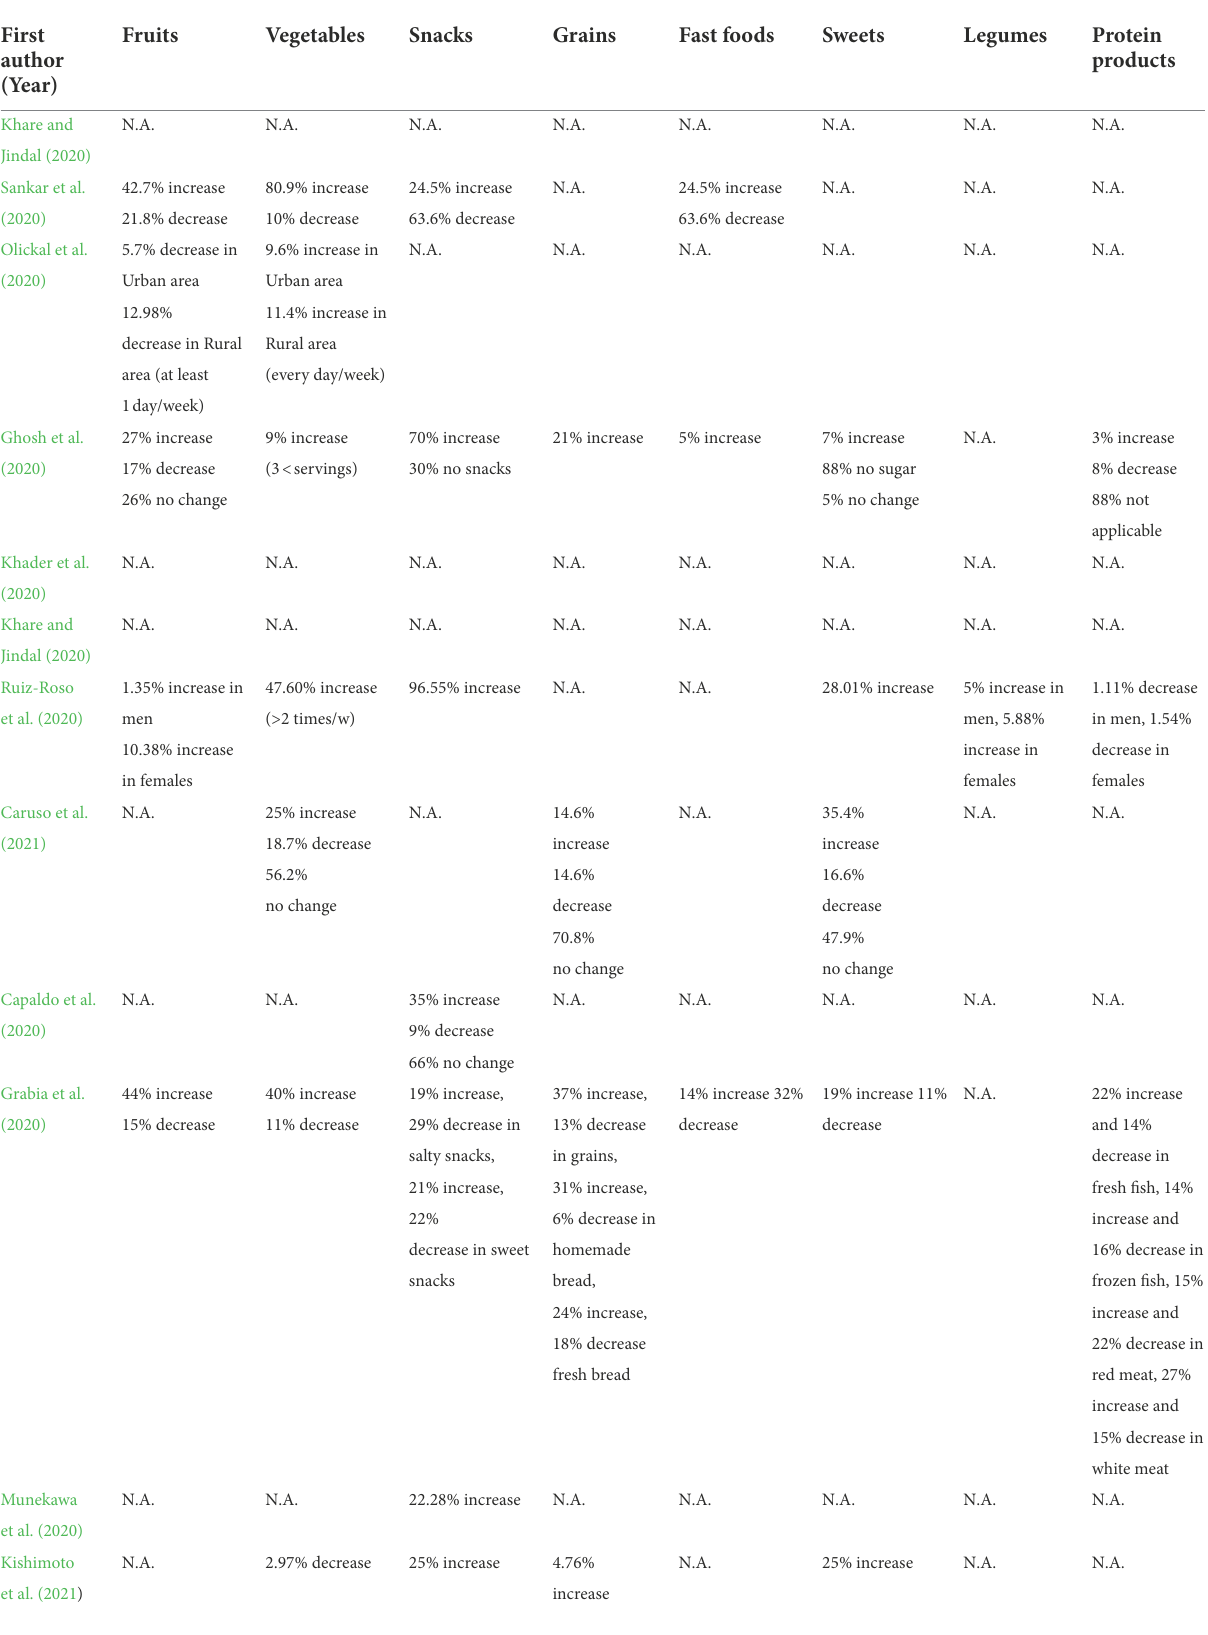
TABLE 3 Changes in food items in diet of diabetic patients during COVID-19 lockdown and social